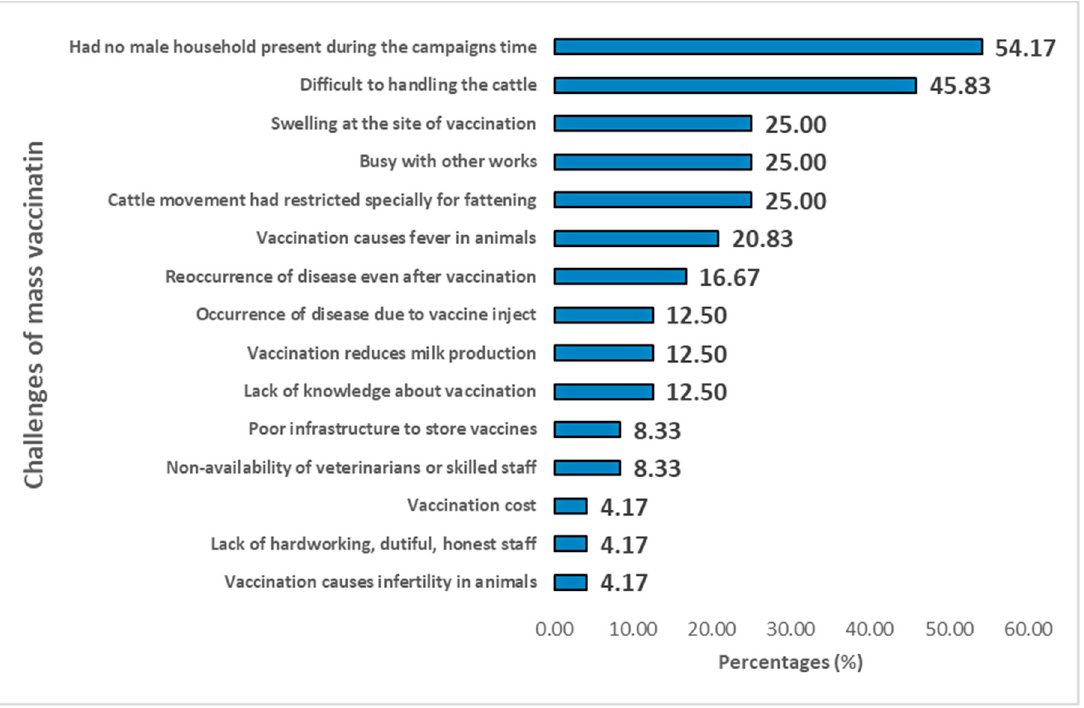
Figure 3. The constraints for mass vaccinations identified in the FGDs in the present study.